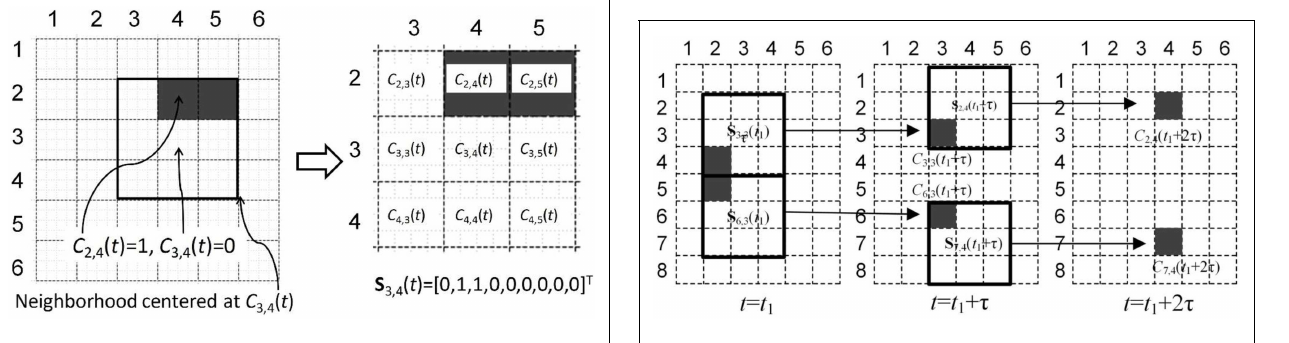
FIGURE 3 | Example neighborhood and neighborhood vector . Solid squares: a neighborhood in a grid map. Filled squares: occupied cells detected by UAVs.